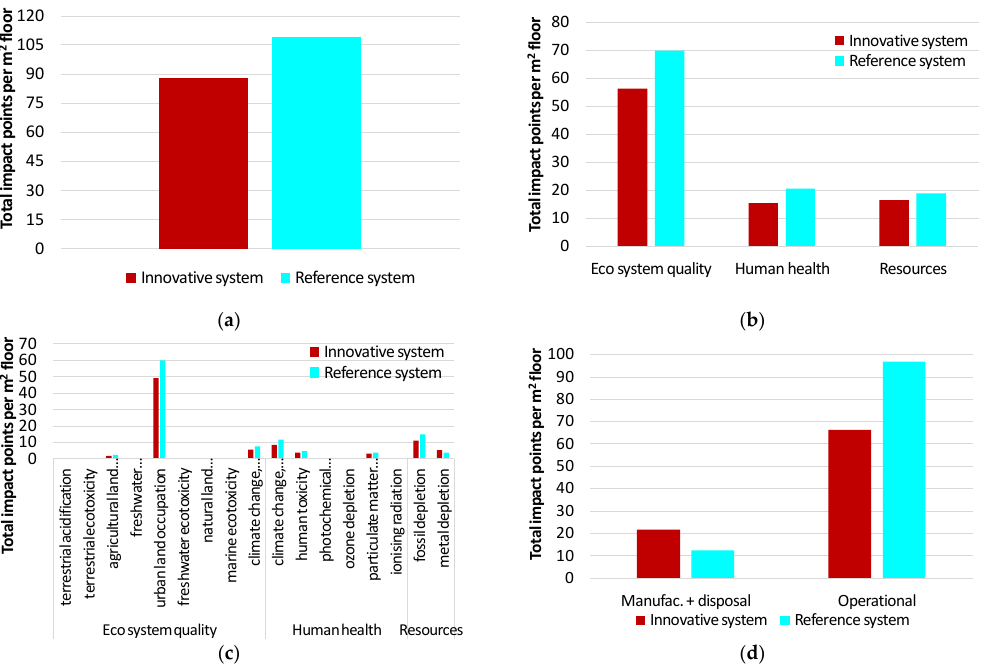
Figure 4. LCA results using ReCiPe indicator: ( a ) total impact points; ( b ) total impact points of damage categories; ( c ) total impact categories towards ReCiPe endpoint single score; ( d ) impact points per life cycle stage.